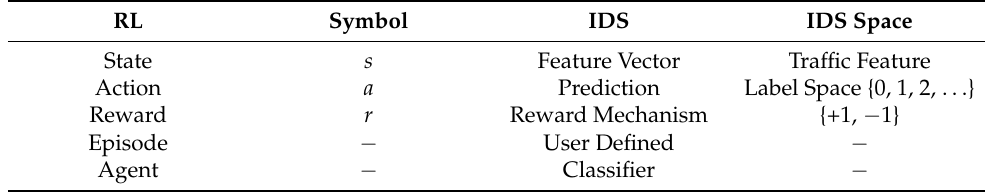
Table 8. RL Module for IDS Framework at the Flow